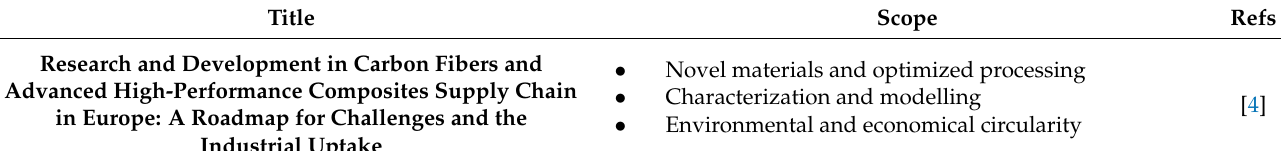
Table 1. Landscape of recent reviews covering machine learning topics across different do- mains/fields of nanomanufacturing and machine learning